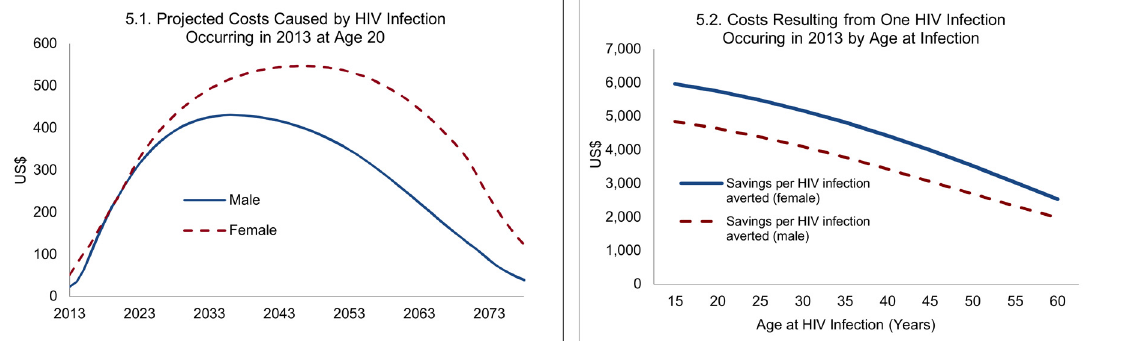
Fig 5. Projected costs caused by one new HIV infection,